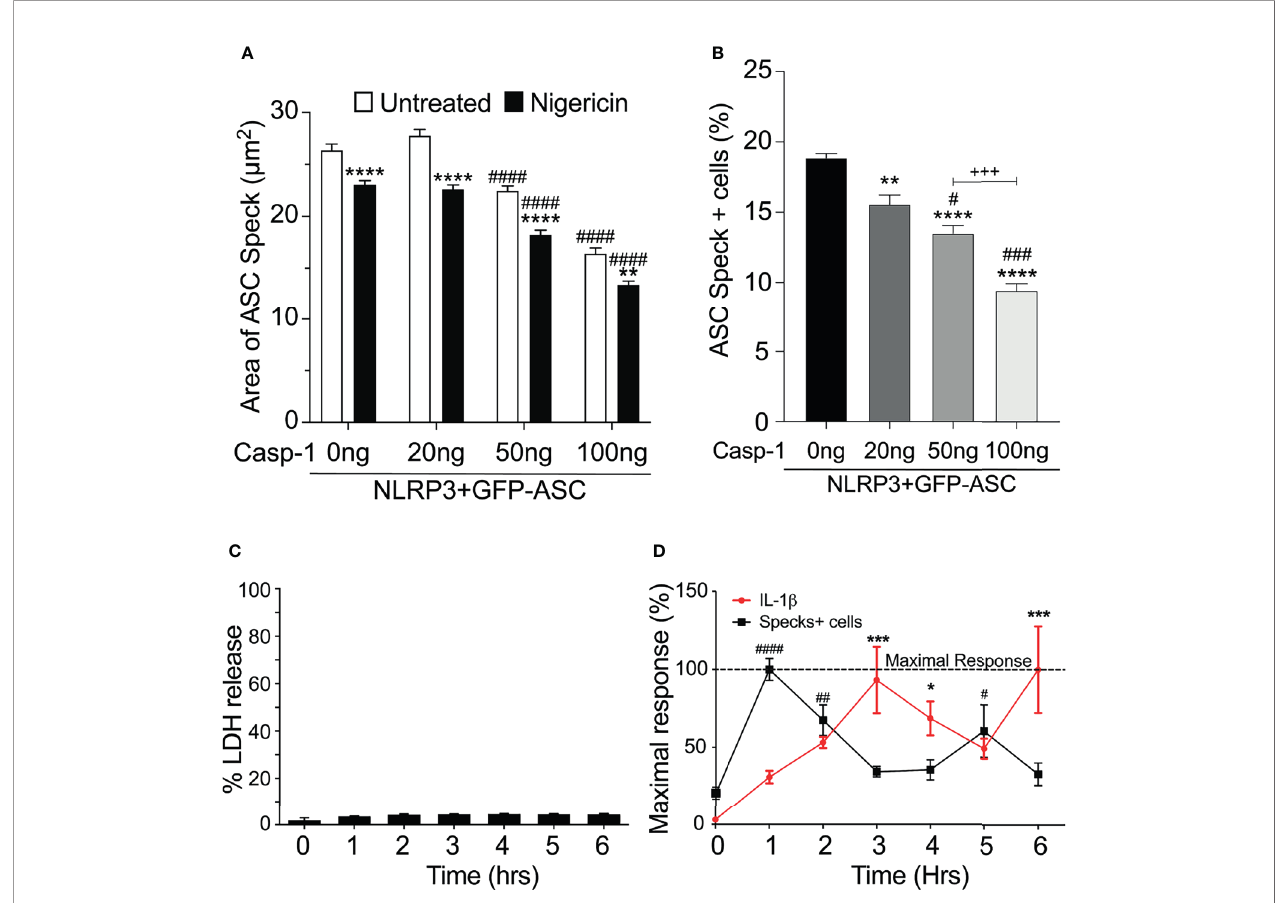
FIGURE 5 | Speck formation and IL-1 b release are cyclic and negatively correlated. (A, B) HEK293T cells were transfected with 50 ng GFP-ASC, 100 ng NLRP3, and 20 or 50 or 100 ng CASP1 and treated with 5 µm nigericin for 2 h. Following nigericin treatment, cells were stained with FLICA, fi xed, and analyzed for the presence of speck and active caspase-1 by ICCE. (C, D) PMA differentiated THP-1 cells are either left untreated (0 h) or treated with 5 m M nigericin for 6 h. Culture supernatant was harvested at the stated time intervals to measure IL-1 b by ELISA and the release of LDH. Cells were fi xed and stained for ASC to detect specks. (A) Cells were analyzed for the presence of ASC speck and active caspase-1 (positive for FLICA staining) from the double-positive gates as analyzed by ICCE. The area of the speck mask was calculated by ICCE. Data represented as mean ± SEM for a minimum of three independent experiments. ** p < 0.01, **** p < 0.0001 for comparison with respective untreated, two-way ANOVA followed by Sidak ’ s multiple comparison tests. #### p < 0.0001 for comparison with respective untreated, two-way ANOVA followed by Dunnett ’ s multiple comparison tests. (B) Cells positive for GFP-ASC were analyzed for the presence of ASC specks by ICCE. Data represented as mean ± SEM for a minimum of three independent experiments. ** p < 0.01, **** p < 0.0001 for comparison with 0 ng transfected casp-1; # p < 0.05, ### p < 0.001 for comparison with 50 ng transfected casp-1; +++ p < 0.001 for comparison between 50 and 100 ng transfected casp-1; one-way ANOVA followed by Tukey ’ s multiple comparison tests. (C) Percentage LDH release compared with 0.09% Triton X-100-lysed cells. (D) Line graph showing the frequency of ASC speck+ cells (red) and the release of IL-1 b (black). Data are normalized to maximal response of speck frequency and released IL-1 b over the time course of the experiment. Data represented as mean ± SEM for a minimum of three independent experiments. * p < 0.05, *** p < 0.001, for comparison of IL-1 b release with untreated control (0 h); # p < 0.05, ## p < 0.01, #### p < 0.0001 for comparison of speck frequency with untreated control (0 h); one-way ANOVA followed by Sidak ’ s multiple comparison